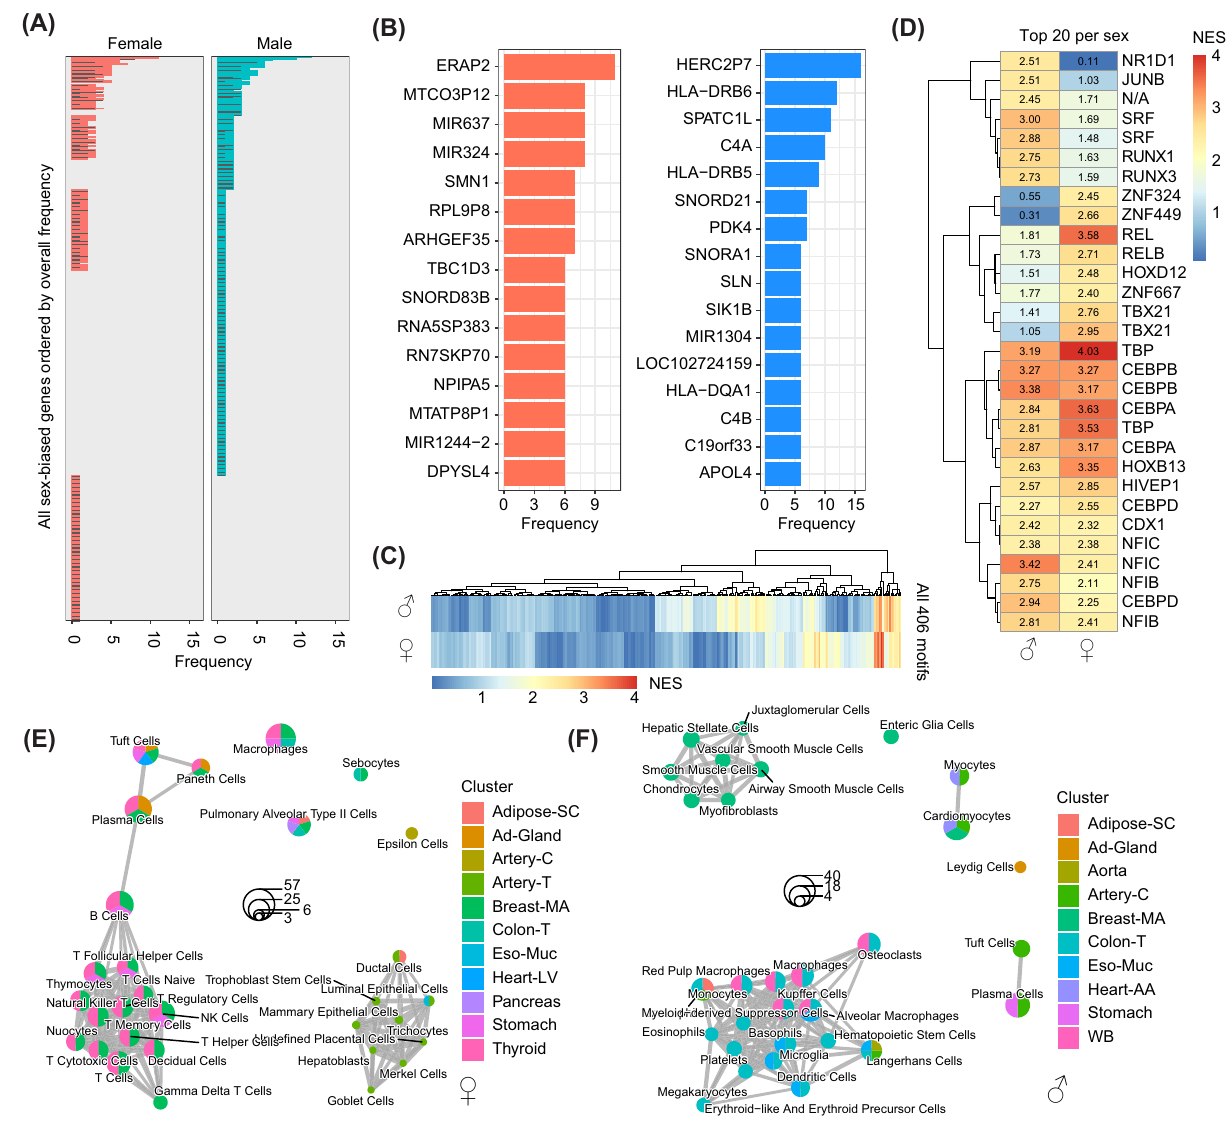
Figure 3. Tissue-transcending sex differences and regulation. ( A ) A barplot indicates how often sex-biased genes are consistent over multiple tissues (female on the left, male on the right). No bar for one sex means that that gene is exclusively sex-biased in the other sex. ( B ) A barplot shows the sex-biased genes that are sex-biased consistently in at least 6 tissues consistently, with ERAP2 being the top gene for females, and HERC2P7 being the top hit for males. ( C ) A heatmap shows the normalized enrichment score (NES) of 406 tested motifs for male-biased (top) and female-biased (bottom) genes in at least two tissues. A NES > 3 is considered significantly enriched. ( D ) A heatmap shows the NES for the top 20 male- and female-biased motifs. ( E ) A cell identity marker enrichment map is plotted for female-biased genes. The top 30 enrichments are shown, with color indicating for which tissue the enrichment was found, while size indicates the overlapping gene count. ( F ) A cell identity marker enrichment map is plotted for male-biased genes. The top 30 enrichments are shown, with color indicating for which tissue the enrichment was found, while size indicates the overlapping gene